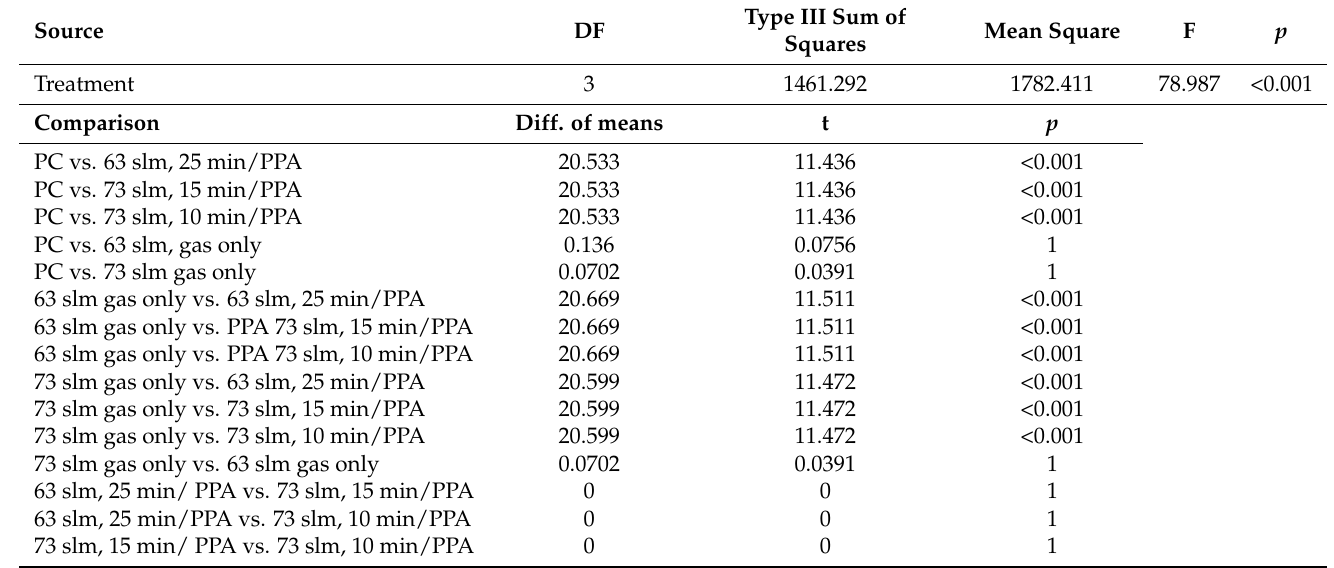
Figure 2. Growth of Pythium mycelia (mm + SE) over a 14-day period for the six different treatments. Four independent runs with seven replicates per treatment were applied ( n = 28). PC: positive control, inoculated no PPA, two controls using gas flow of air only without microwave torch ignition (gas only) and three different PPA treatment modes. (PPA): Note that data points for PPA treatments (blue, red, green dots) are overlaying. Table 1. Results of repeated-measure one-way ANOVA (RM-ANOVA), followed by Holm–Sidak comparison.